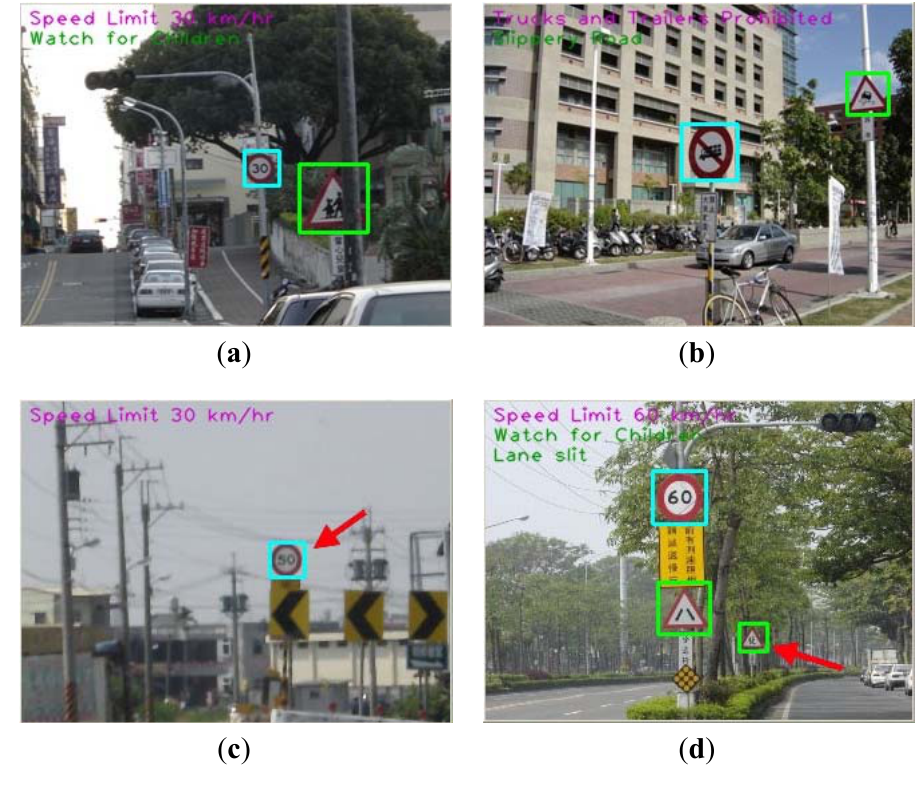
case; ( d ) is two correct and one error